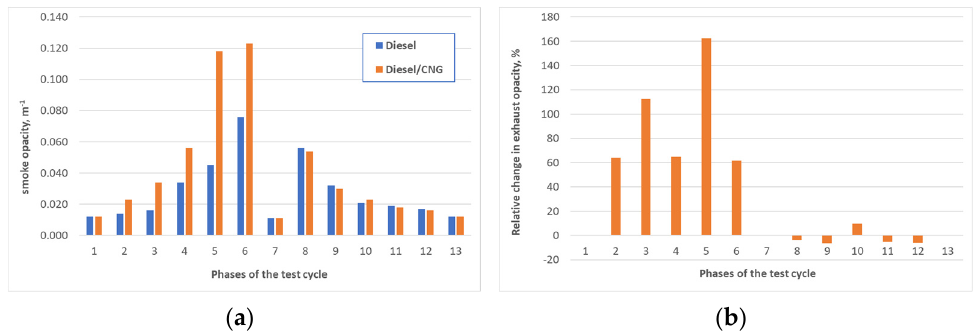
Figure 17. Extinction coefficient of absorbed radiation during the R49 test on diesel fuel and diesel/CNG supply for individual phases of the test: ( a ) extinction coefficient of absorbed radiation and ( b ) relative change in the extinction coefficient of absorbed radiation.